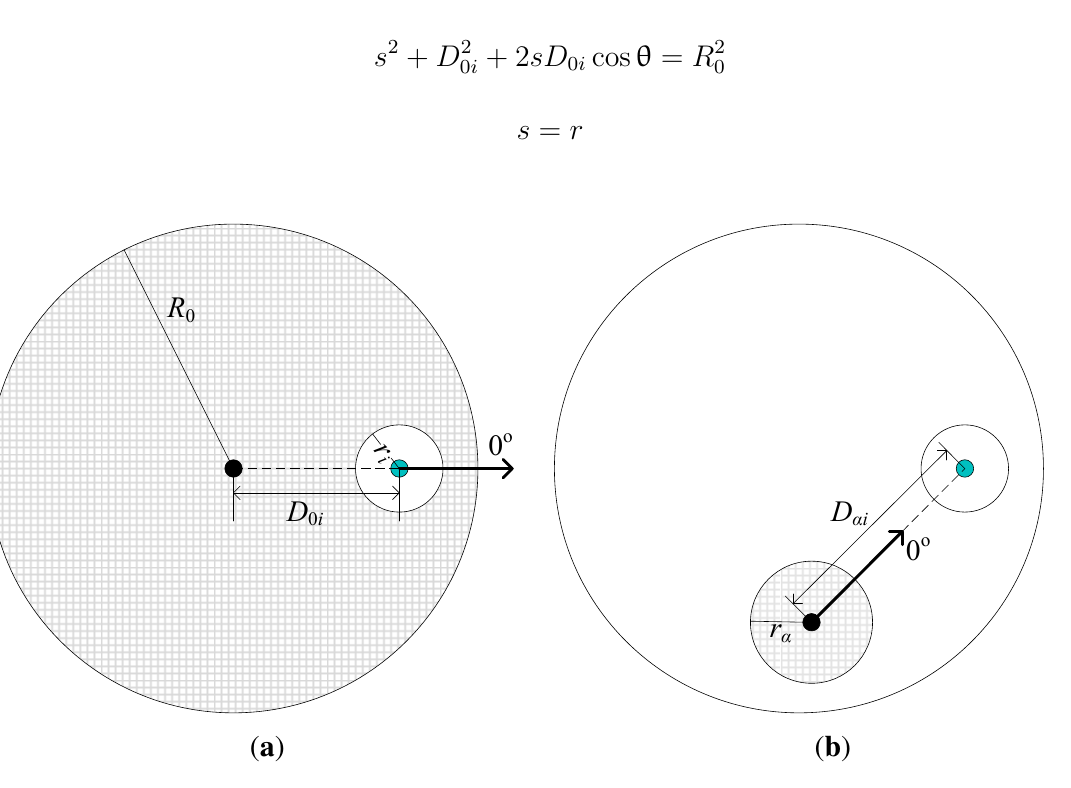
Figure A1. The polar coordinate systems for calculating the ICI. ( a ) To calculate x ; ( b ) to calculate y